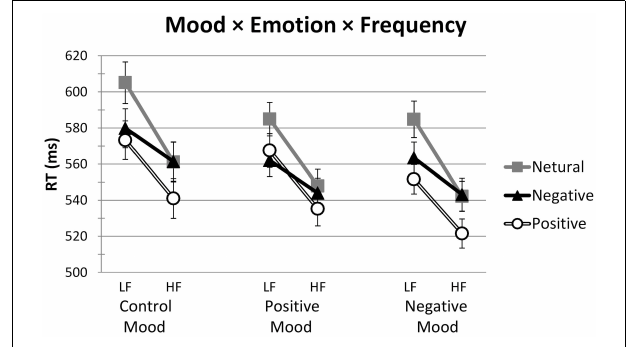
FIGURE 1 | Mean RT (ms), with SE bars, on words as a function of Mood (Control, Positive, Negative), Emotion (Positive, Negative, Neutral), and Frequency (LF, HF). LF, low frequency; HF, high frequency.